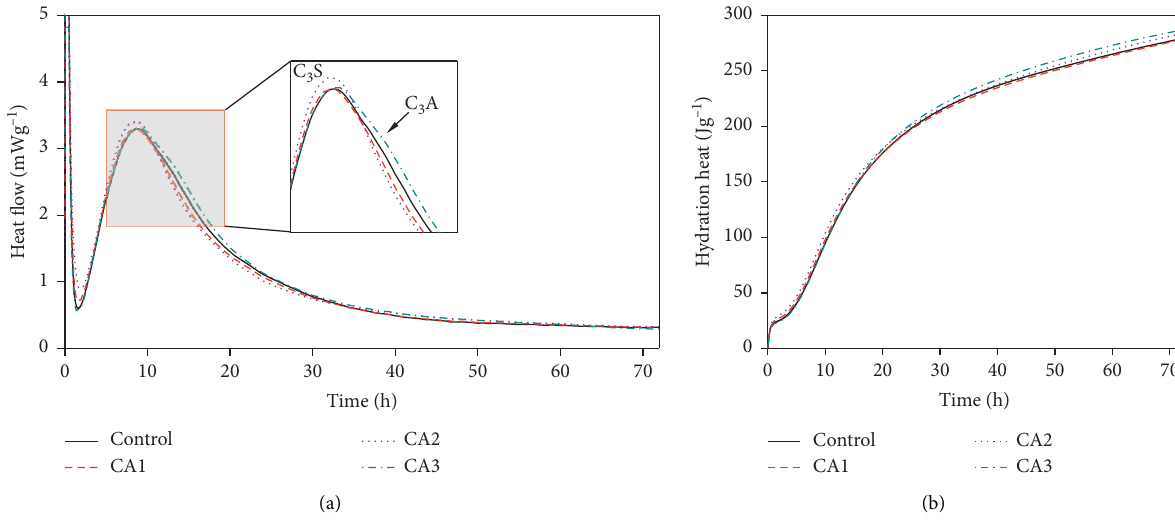
Figure 1: (a) Exothermic rates of hydration. (b) Cement samples’ hydration heats.